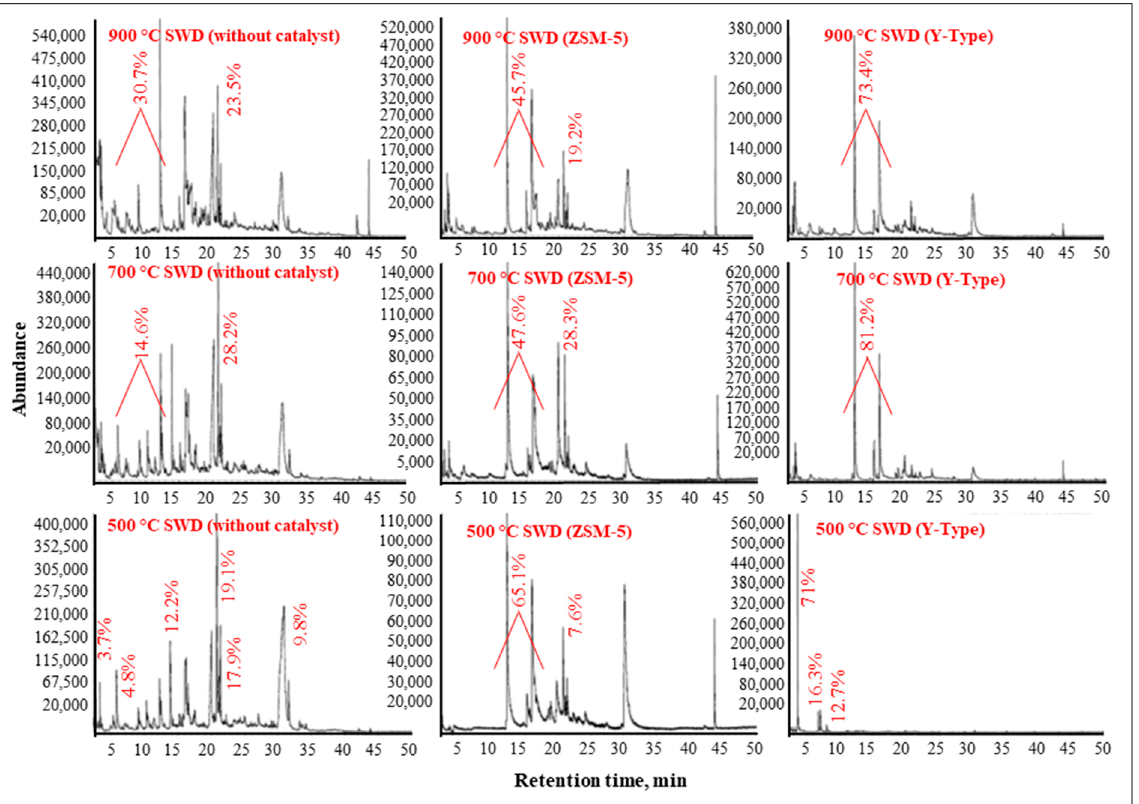
Figure 7. Liquid product analysis by the